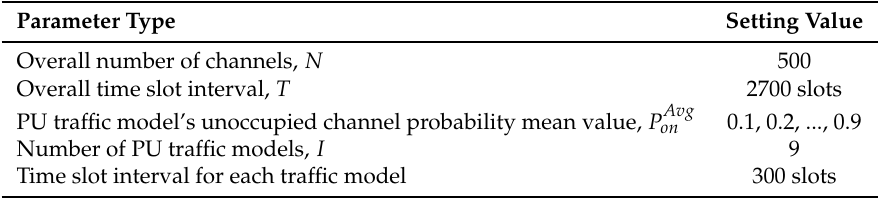
Table 5. Simulation test parameter types and setting values.